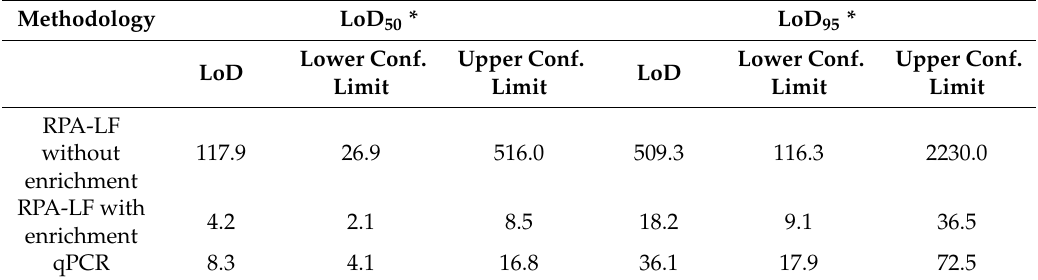
Figure 5. Comparison of the LoD 50 with the 95% confidence upper and lower limits, obtained with di ff erent enrichment times (0, 8 h, 14 h, 24 h) in ONE broth. LoD 50 calculated with PODLOD software and represented in CFU / cm 2 . Table 4. Limit of Detection of L. monocytogenes with developed methodology and